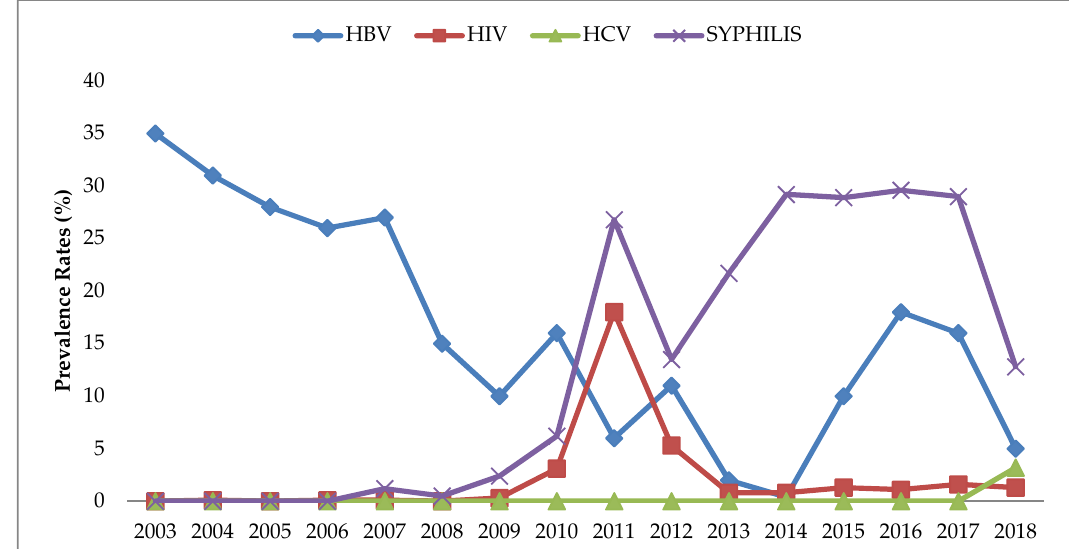
Figure 2. The trend of single infection by hepatitis B virus (HBV), human immunodeficiency virus (HIV), Syphilis and hepatitis C virus (HCV) from 2003–2018, based on calculated estimated prevalence rates.